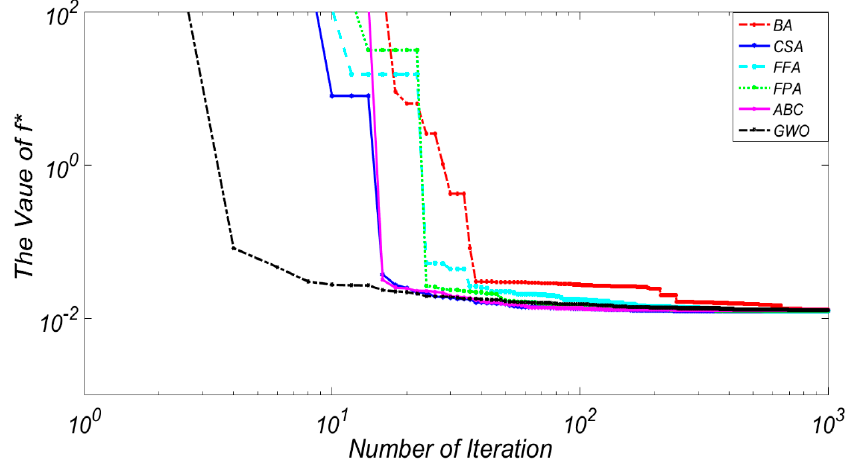
Figure 12. The tension/compression spring problem results.